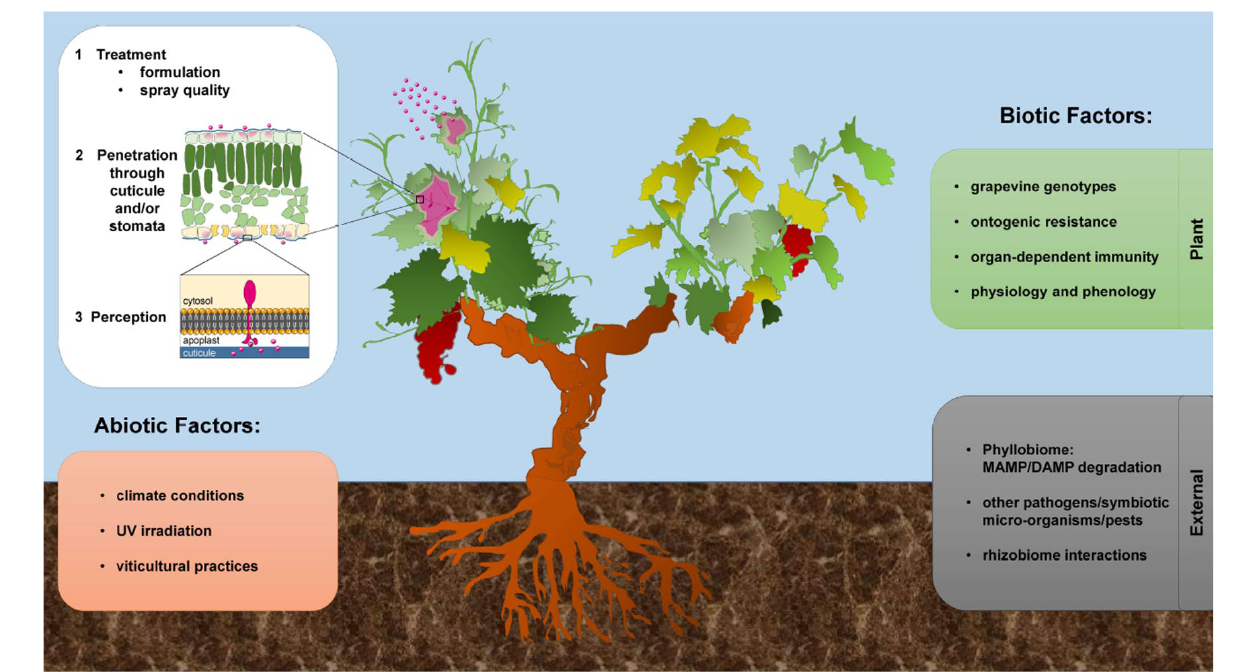
FIGURE 3 | Effect of different factors influencing grapevine induced resistance in